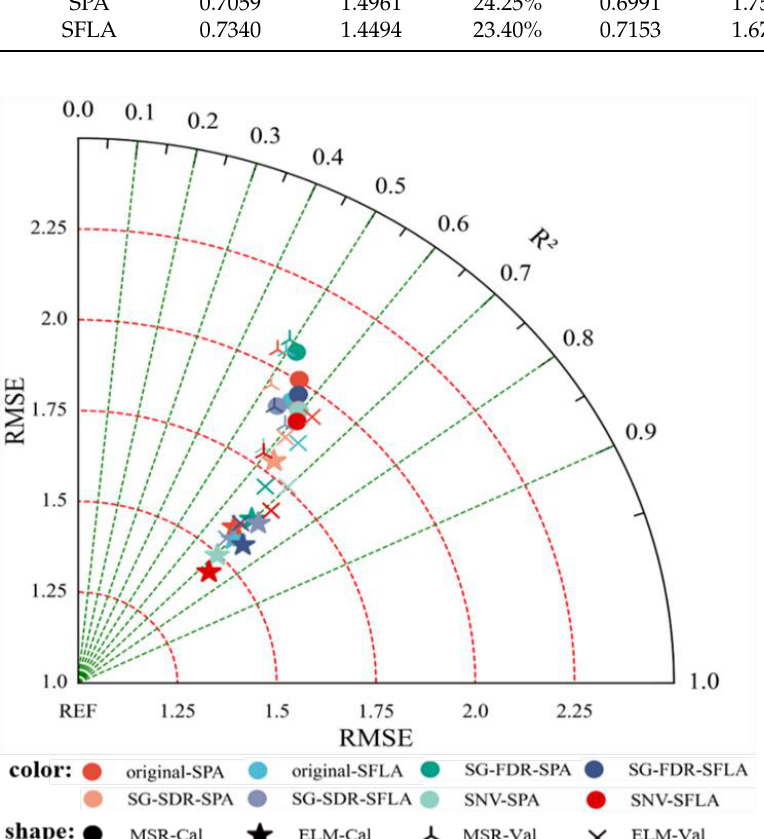
Figure 7. Cotton LAI monitoring model training sets (Cal) and validation sets (Val) result based on spectral reflectance: resultant Taylor diagram.